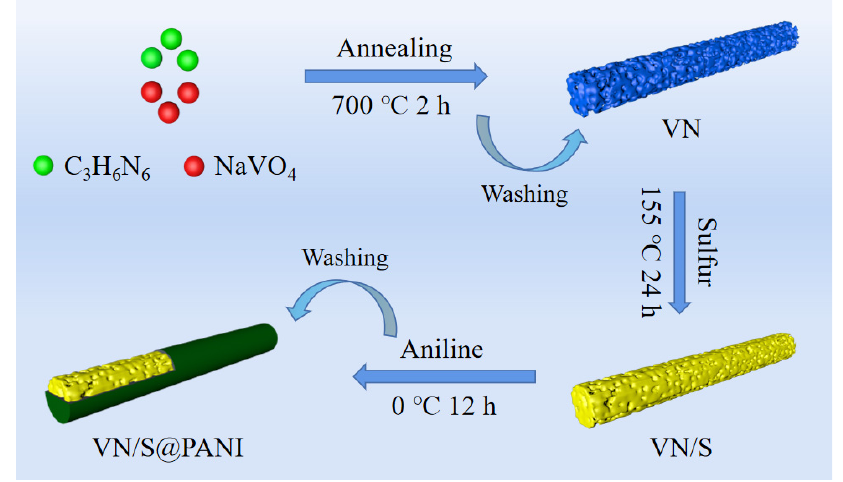
Figure 1. Schematic synthesis process of VN/S@PANI composite.